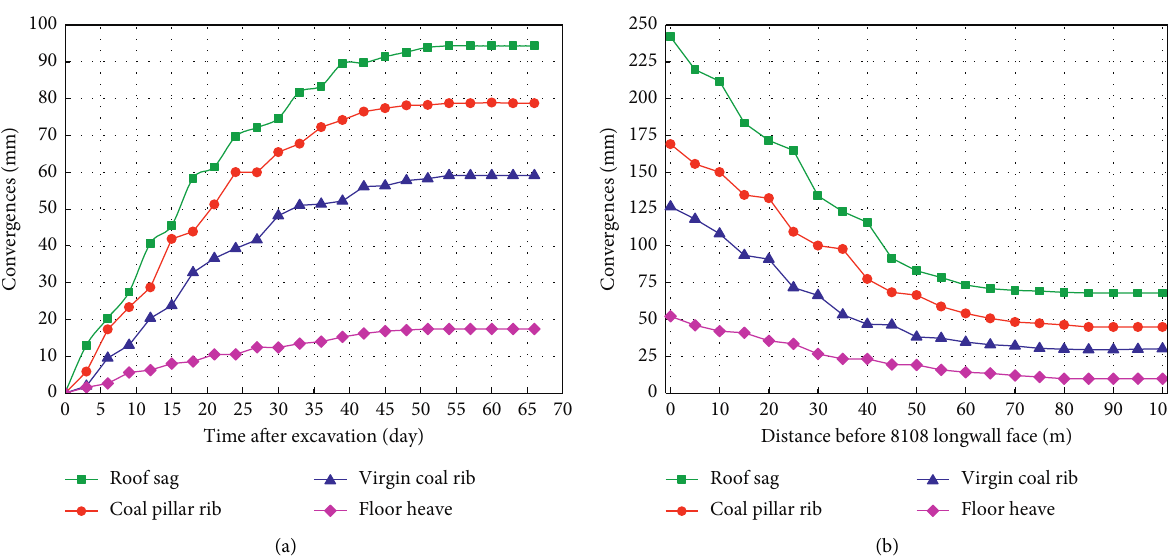
Figure 19: Measurement of 8108 headgate deformation. (a) During the 8108 headgate excavation. (b) During the 8108 panel